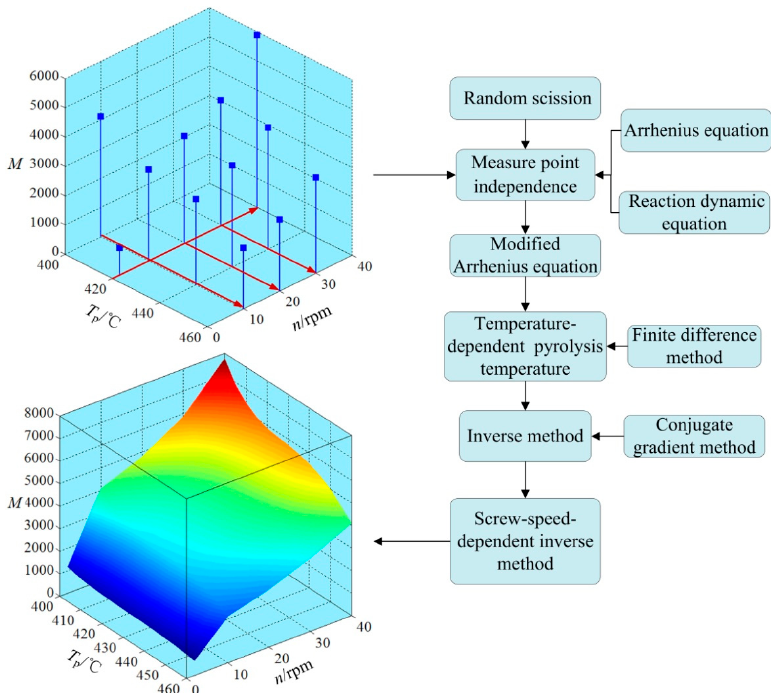
Figure 7. Procedure to monitor NAMW of PEW from the pyrolysis of waste HDPE by extrusion. Table 2. The arrangements of measure points under different values of p .